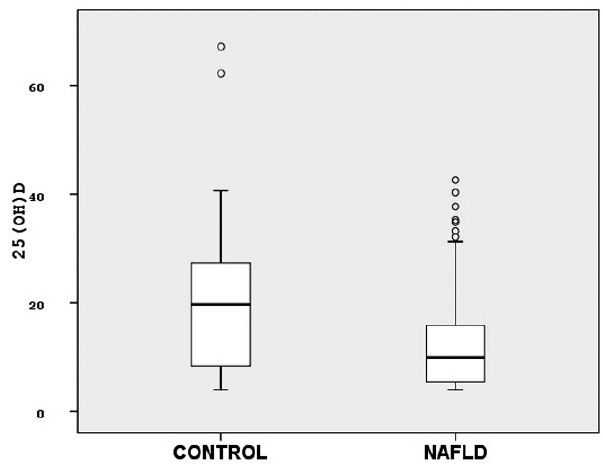
Figure 1 - Comparison of 25(OH)D levels (ng/dl) between the NAFLD and the control groups.